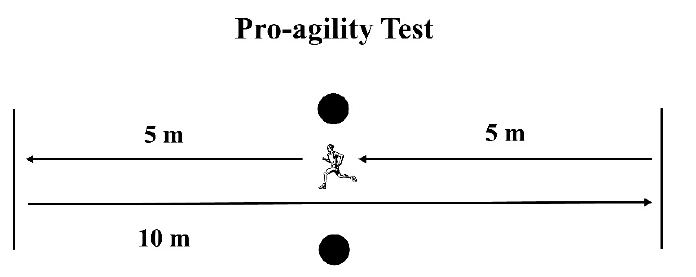
Figure 3. Schematic representation of the pro-agility test. Circles represent the position of the pho- tocells.